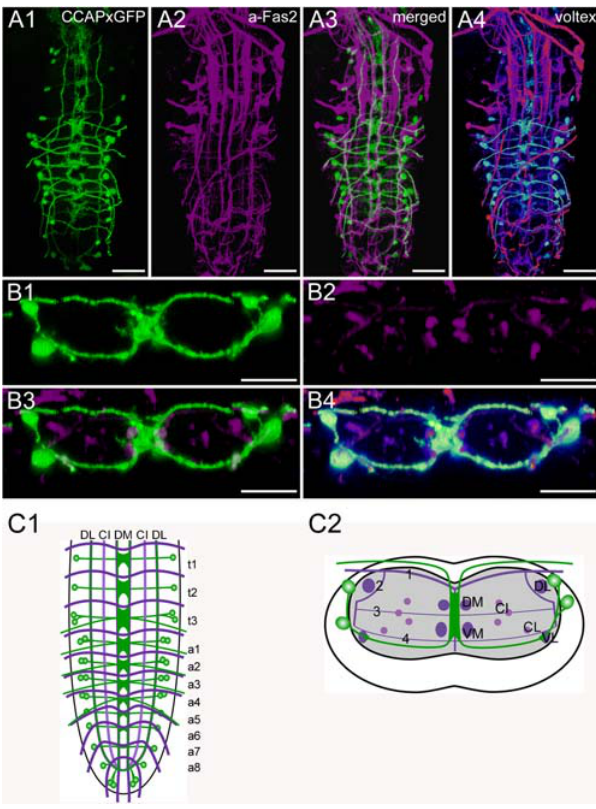
Figure 5. Morphology of corazonin neurons. Mapping of corazonin-IR neurons in whole-mount preparations of the thoracic and abdominal neuromeres of L3 larva in the Fas2 landmark system. A) Ventral view. B) Transversal view at the height of neuromere a6. C) Idealized dorsal scheme. D) Idealized transverse scheme. Scale bars: 50 m m in A ), 25 m m in B ). Immunostaining is shown in green, Fas2 in magenta.